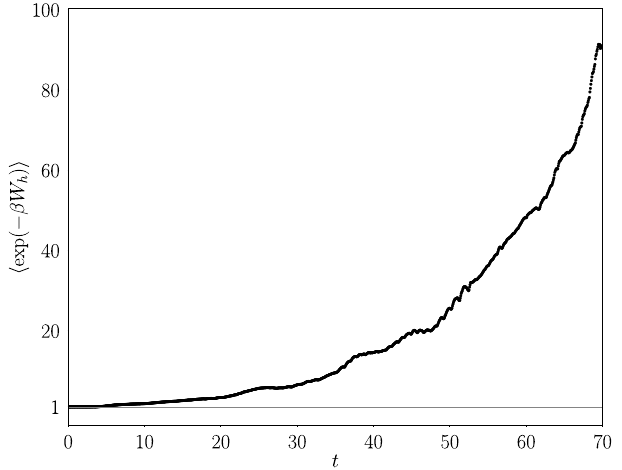
Figure 14. Estimation of the efficacy parameter ( γ ) as a function of time for a system with p = 0.2 and M l = 1